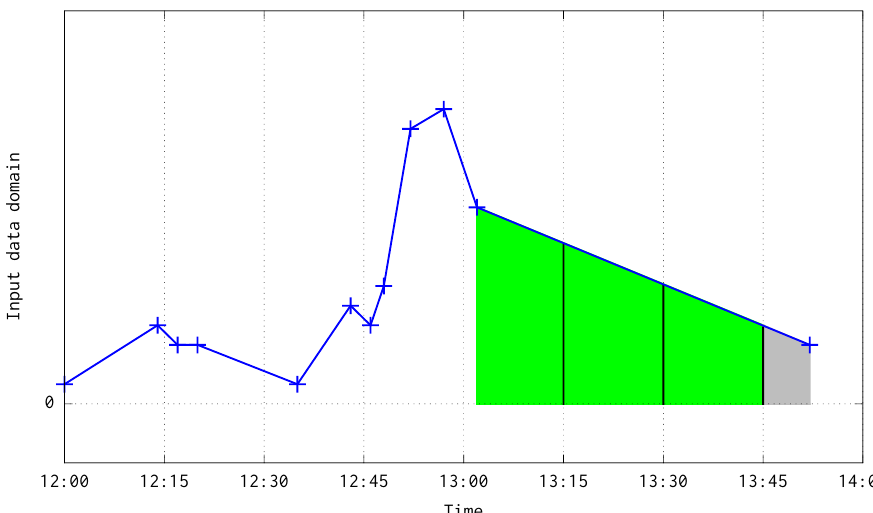
Figure 6. Illustration about the interpolation and integration of previous and current input data pairs when they are in non consecutive quarters. In green color has been depicted the interpolation of the computed quarters that end at 13:15, 13:30 and 13:45. In gray color has been shown the interpolation aggregated to the following quarter that would end at